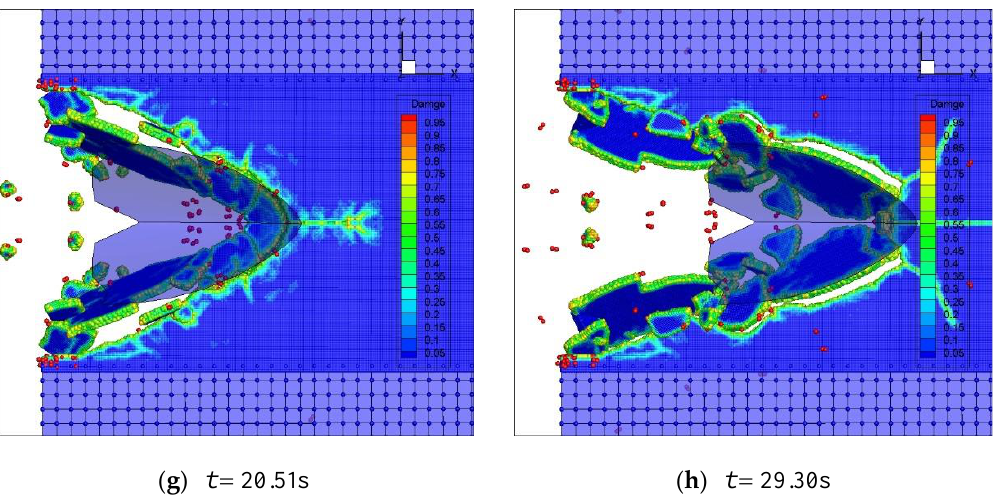
Figure 11. Ice-breaking process of icebreaker navigating in level ice simulated by PD-FEM coupling model.